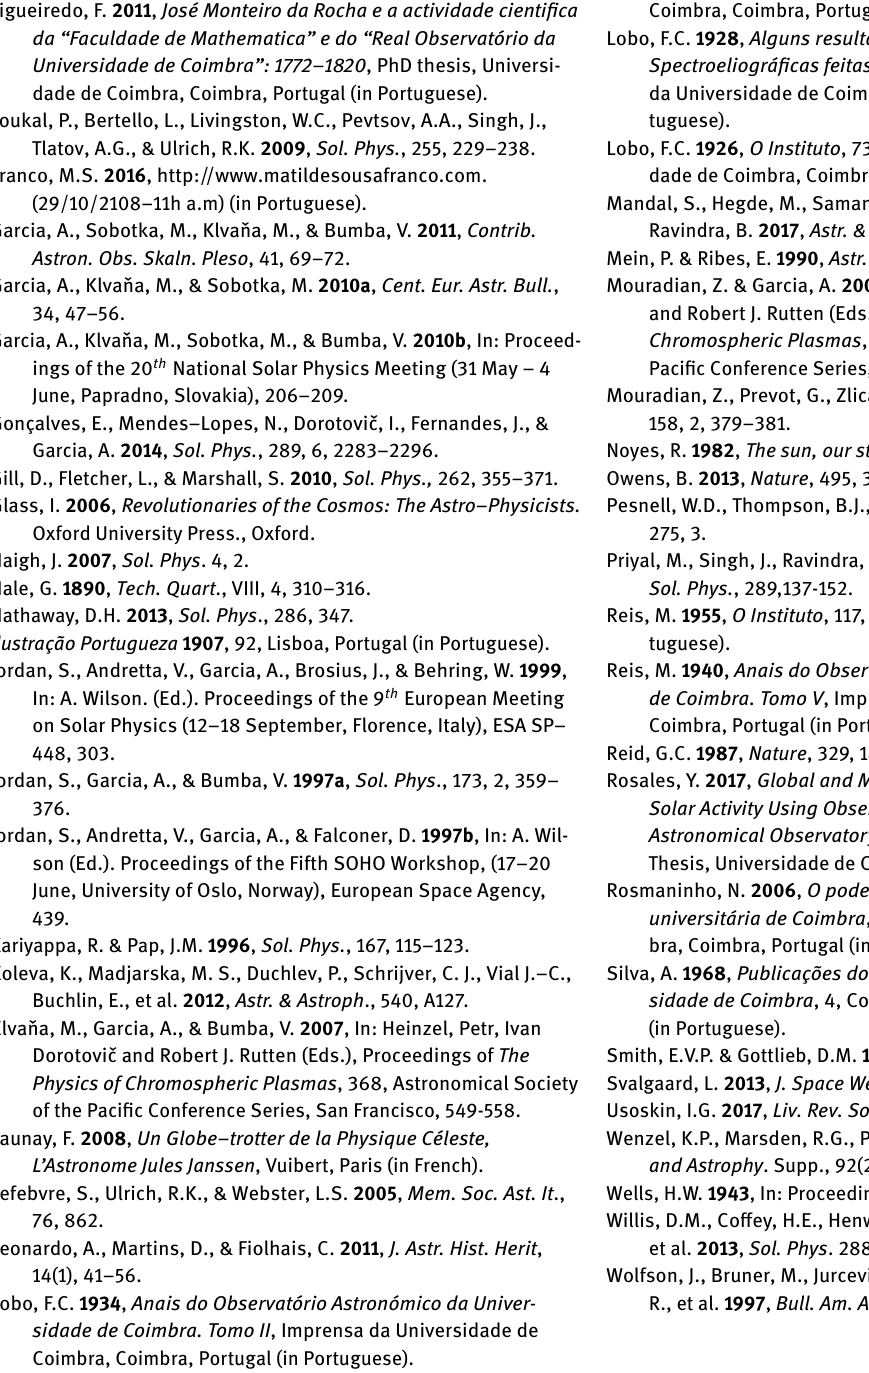
Figueiredo, F. 2011 , José Monteiro da Rocha e a actividade